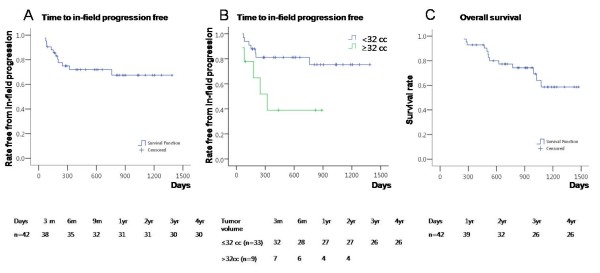
In-field progression-free survival rates and overall survival rates . A) In-field progression-free survival rates. B) Patients with a tumor volume of < 32 cc had longer in-field progression-free survival rates than those with a tumor volume of ≥ 32 cc (P = 0.026 by log rank test). C) Overall survival rates.